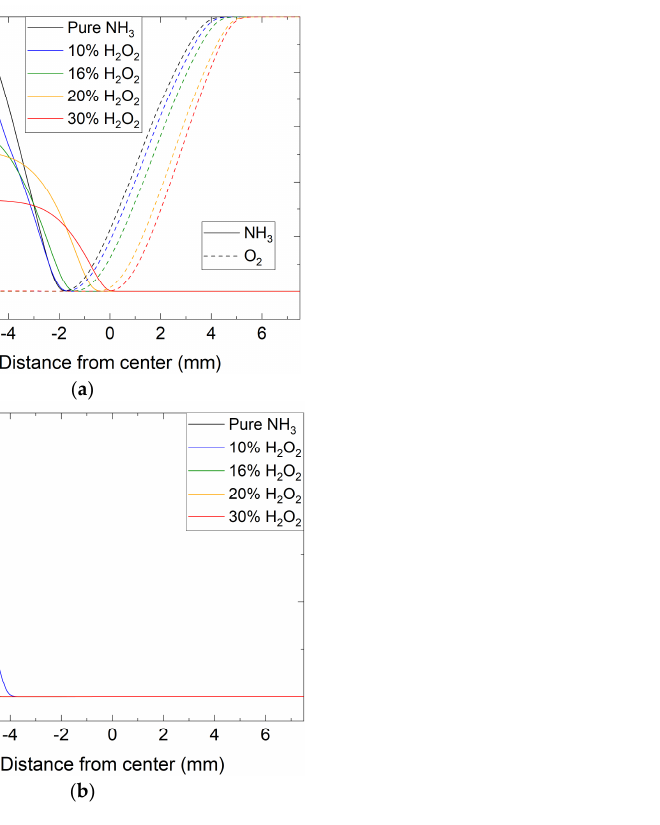
Figure 5. NH 3 and O 2 ( a ), as well as H 2 O 2 ( b ), mole fraction distributions along the burner center line.